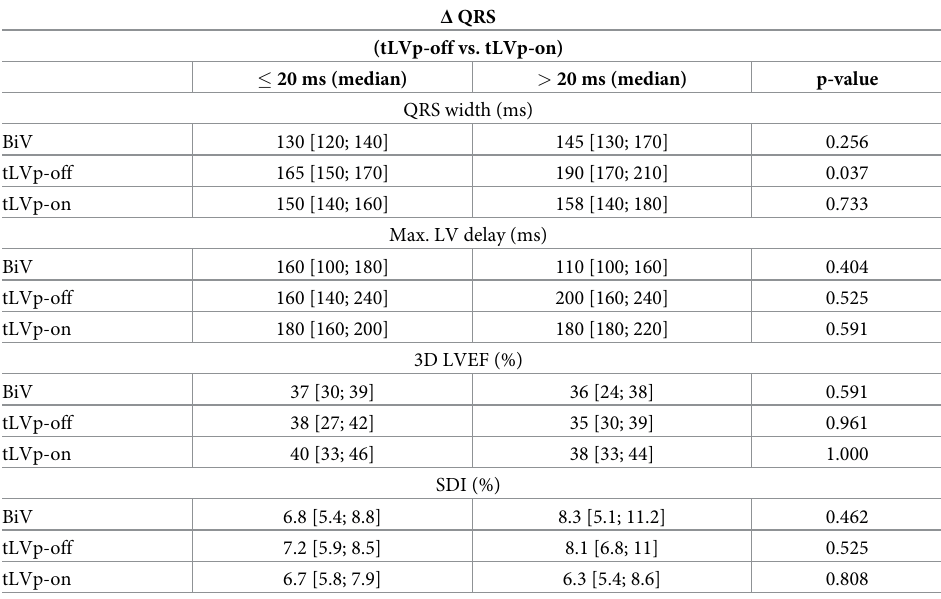
Table 2. Electrocardiographic and echocardiographic markers depending on the amount of QRS shortening by tLVp with regard to intrinsic QRS complex. Δ